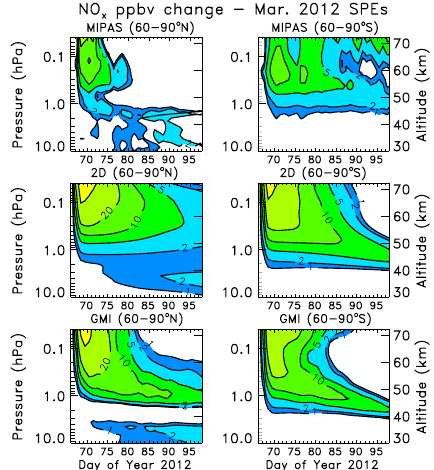
Fig. 10. Daily averaged NO x (NO + NO 2 ) changes from DoY 66 (6 March) 2012 values for 60–90 ◦ N ( left plots ) and 60–90 ◦ S ( right plots ) as measured by MIPAS ( Top ) and calculated by the GSFC 2-D model ( Middle ) and the GMI 3-D CTM ( Bottom ). The contour intervals for the NO x differences are 1, 2, 5, 10, 20, and